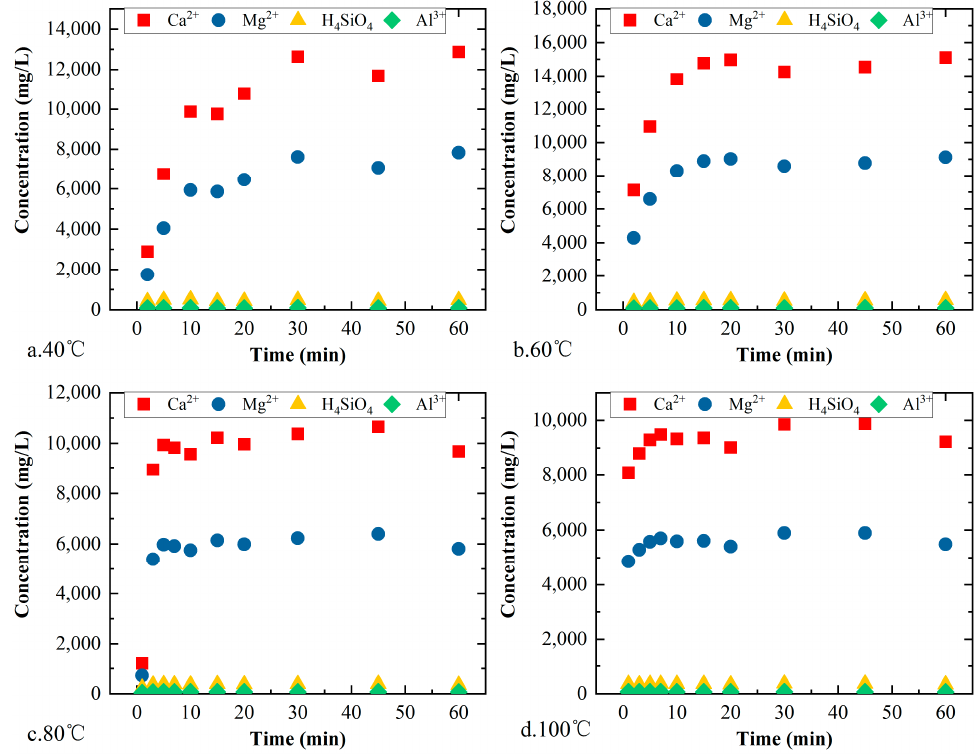
Figure 8. Ion concentrations of the acid after the reaction of core R2 at ( a ) 40 °C; ( b ) 60 °C; ( c ) 80 °C; ( d ) 100 °C.